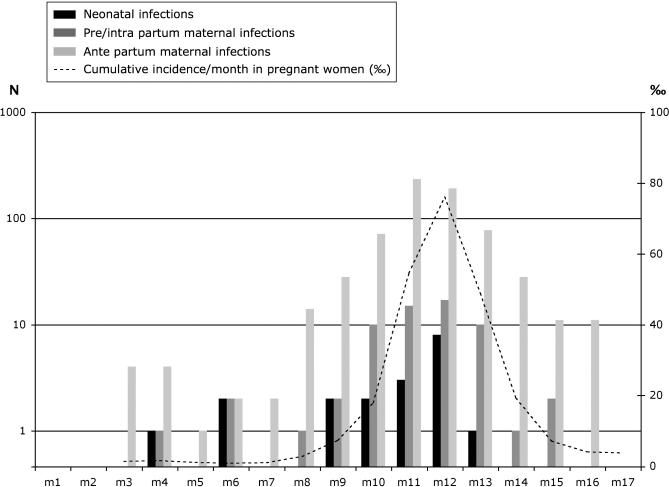
Monthly Evolution of Neonatal, Maternal Pre- and Intrapartum, and Antepartum Chikungunya Cases between March 2005 (m1) and June 2006 (m16), First Sud-Réunion Outbreak, in Saint-Pierre